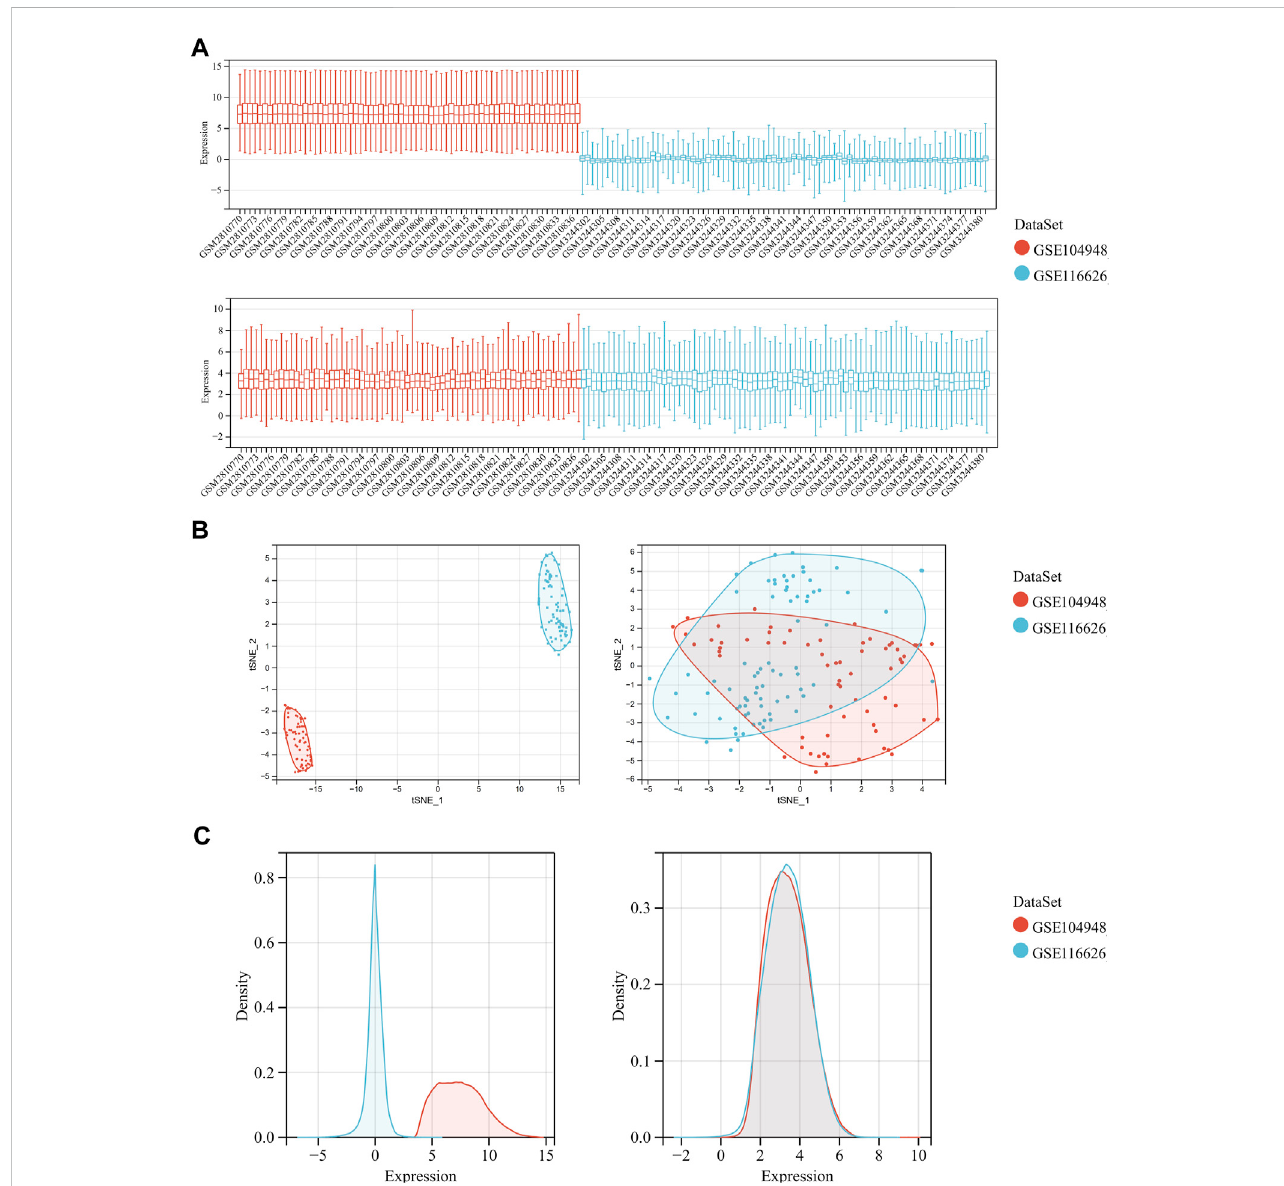
FIGURE 2 Data preprocessing of GSE104948 and GSE116626. (A) Box diagram showing the sample distribution of each data set before batch correction and after batch correction. (B) UMAP analysis showing the sample distribution of each data set before batch correction and after batch correction. (C) Density map showing the sample distribution of each data set before batch correction and after batch